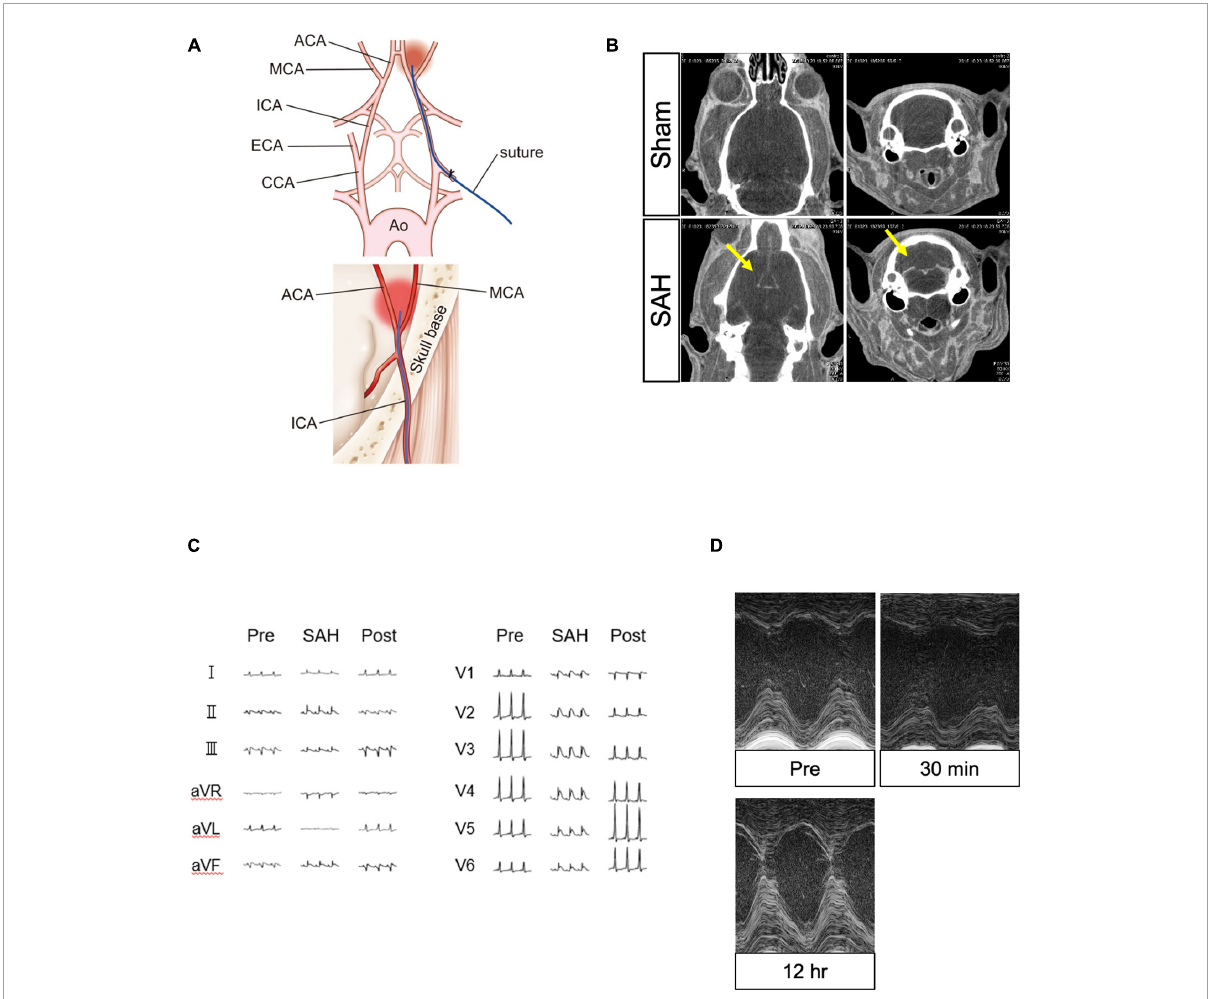
FIGURE1 Surgical procedure for creating the SAH model and confirmation of the model using several modalities. (A) Surgical procedure to create the model of SAH puncture. (B) Contrast leakage was visible in the subarachnoid space in the SAH group (yellow arrow) but not in the sham group. (C) ECG changes in the SAH group recorded before, during, and after the SAH procedure. (D) TTE changes in the SAH group obtained before and after the SAH procedure. ACA, anterior cerebral artery; Ao, aorta; CCA, common carotid artery; ECA, external carotid artery; ECG, electrocardiography; ICA, internal carotid artery; MCA, middle cerebral artery; SAH, subarachnoid hemorrhage; and TTE,